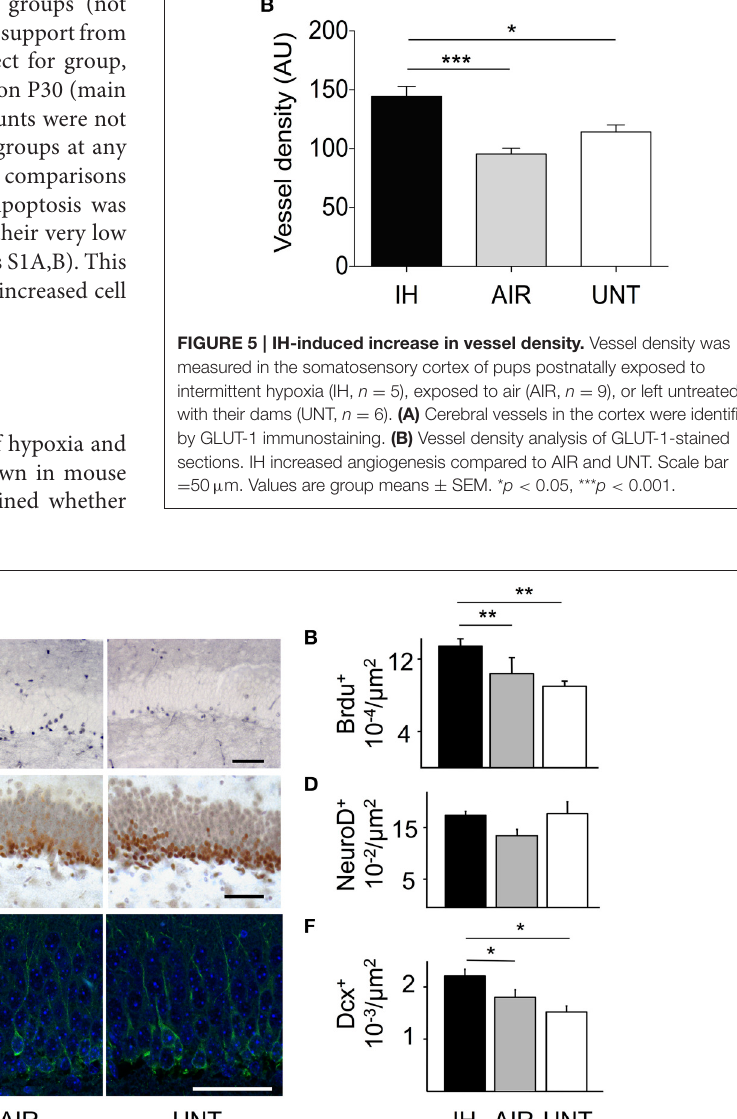
Frontiers in Physiology |